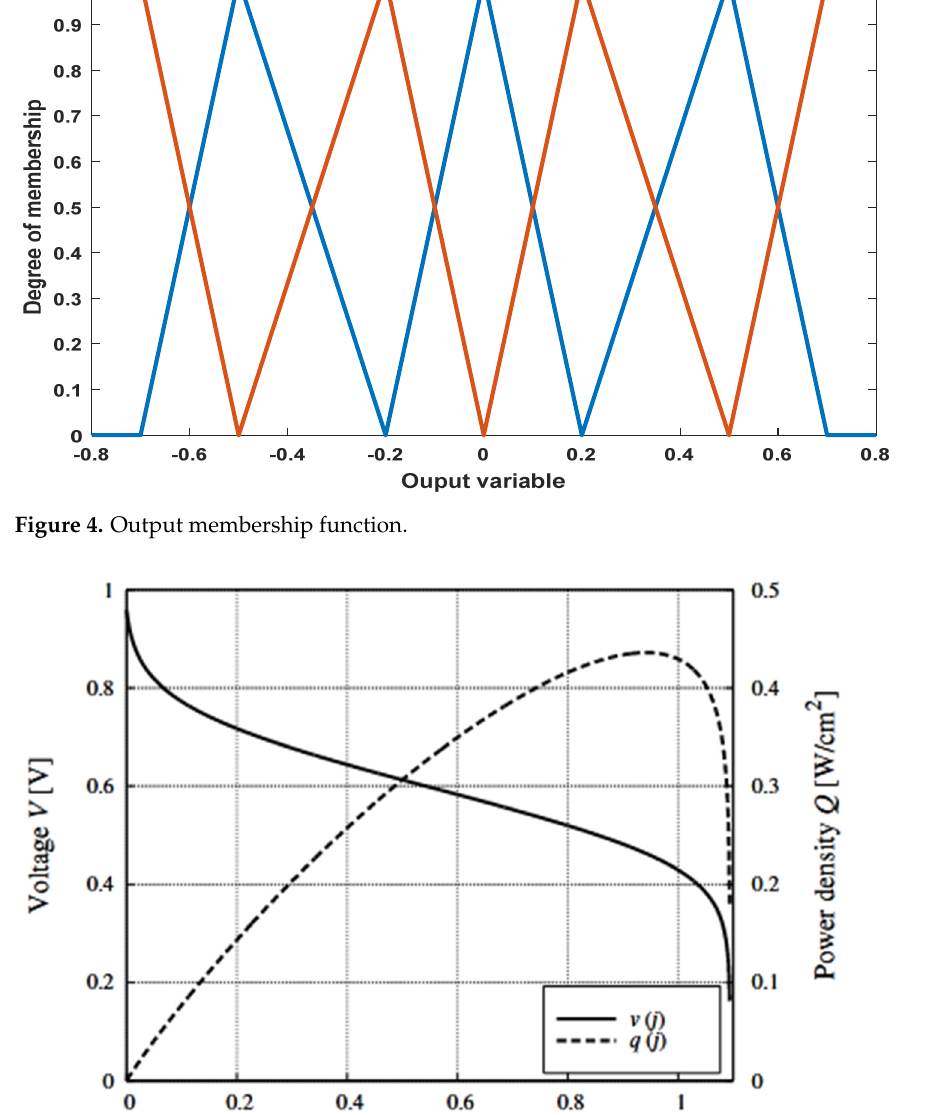
Table 2. Fuzzy variable language.